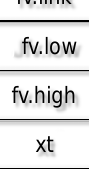
A node can be made measure light exposure, and fuzzify it with the code: lightexp measure apply The word measure fetches the xt fie d of the fuzzy variable that precedes it and executes the associa